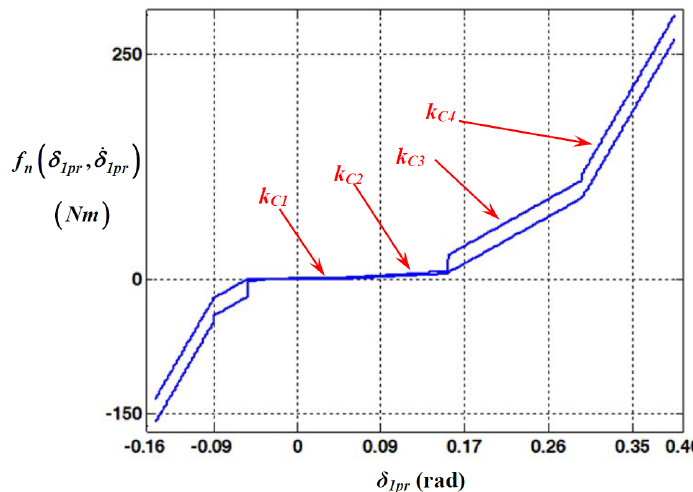
Figure 2. Clutch torque profile of multi-staged clutch dampers with the nonlinear function   , f    n 1Pr 1Pr